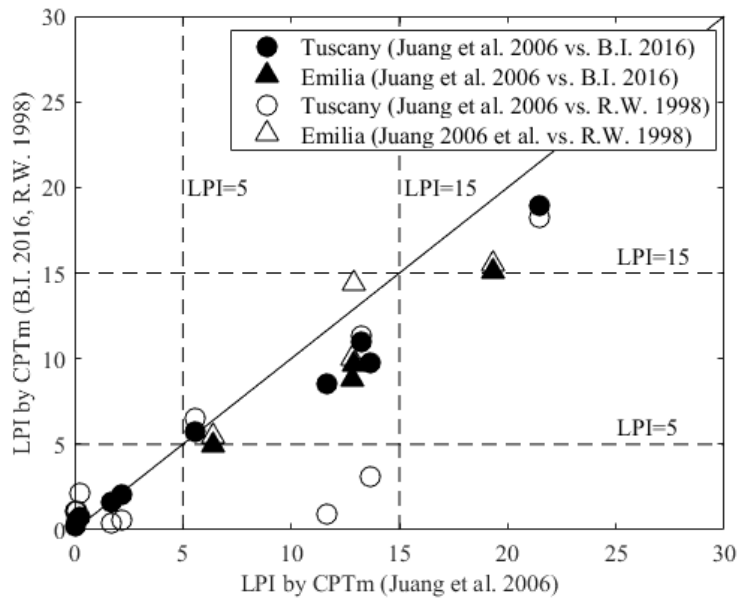
Figure 11. Comparison between the values of the LPI obtained with corrected CPTm data by using all